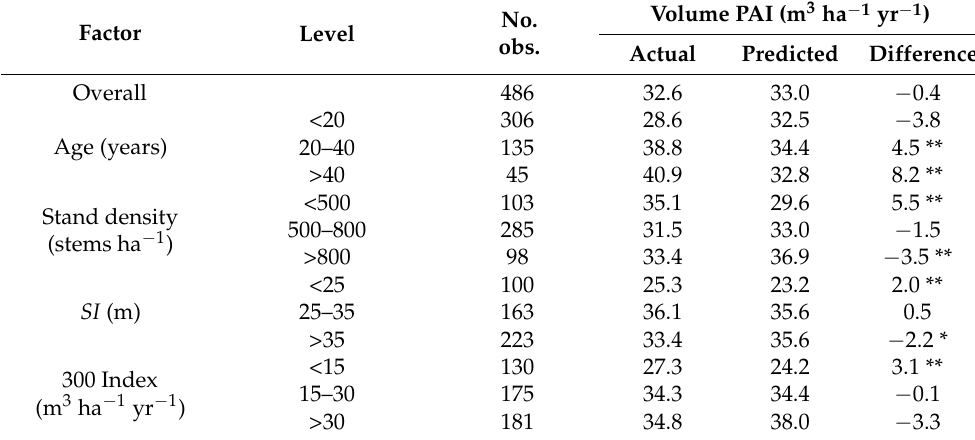
Table 12. Performance of the growth model across a range of stand variables and site factors. For each measured growth increment, actual volume periodic annual increment (PAI) was compared with its prediction, and the mean difference was tested using t -tests. The number of observations (No. obs.) used in each category is also shown. Equations (15), (18) and (9) were used to predict MTH , D q and N , respectively, using their values at the start of the increment as initial values, and Equation (10) was used to estimate stem volume from these metrics.